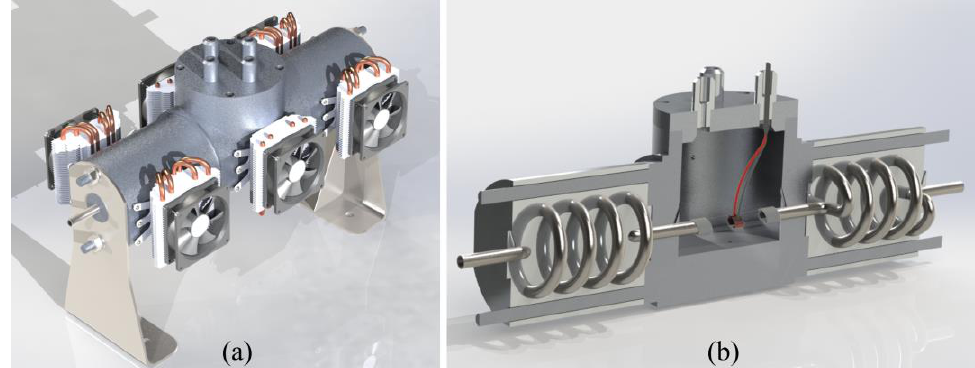
Figure 2. Parts of the metal block: ( a ) external view with Peltier cells and ( b ) internal view, in which the helical steel tube cast in aluminum and the environment of the sensors and electronic parts can be seen.